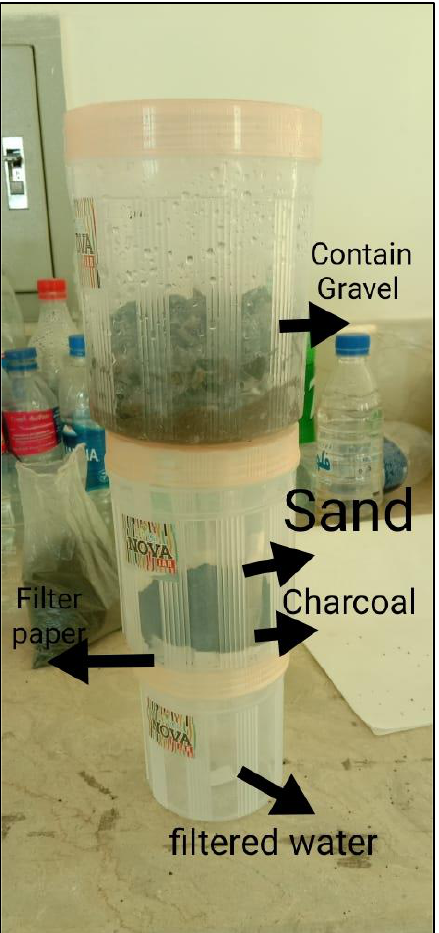
Figure 1: Physical design of the filtration system